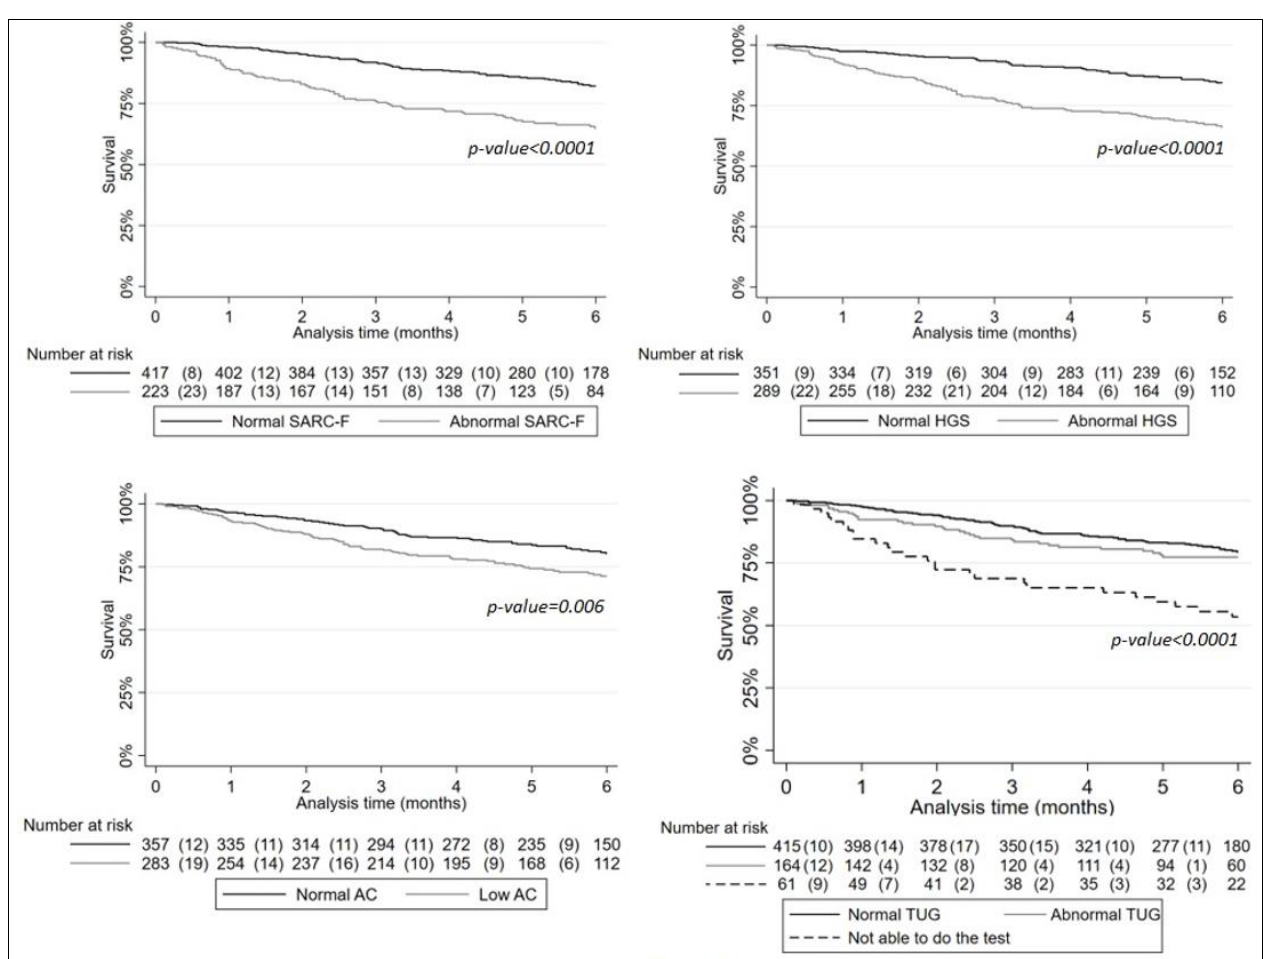
Figure 2. Kaplan–Meier survival curves for four criteria for probable sarcopenia.